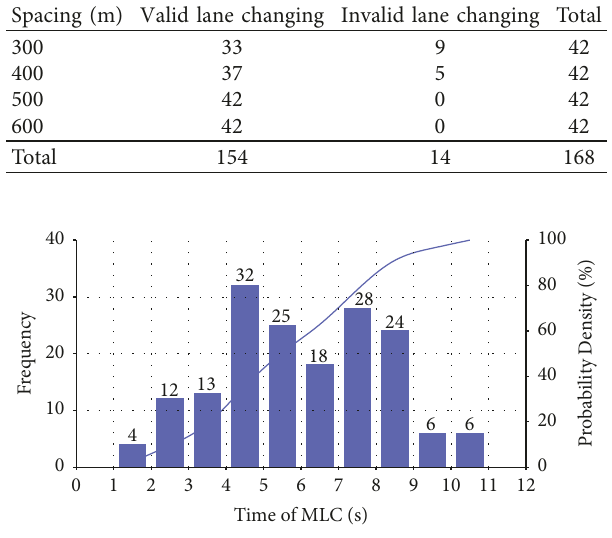
Figure 4: Total distribution of